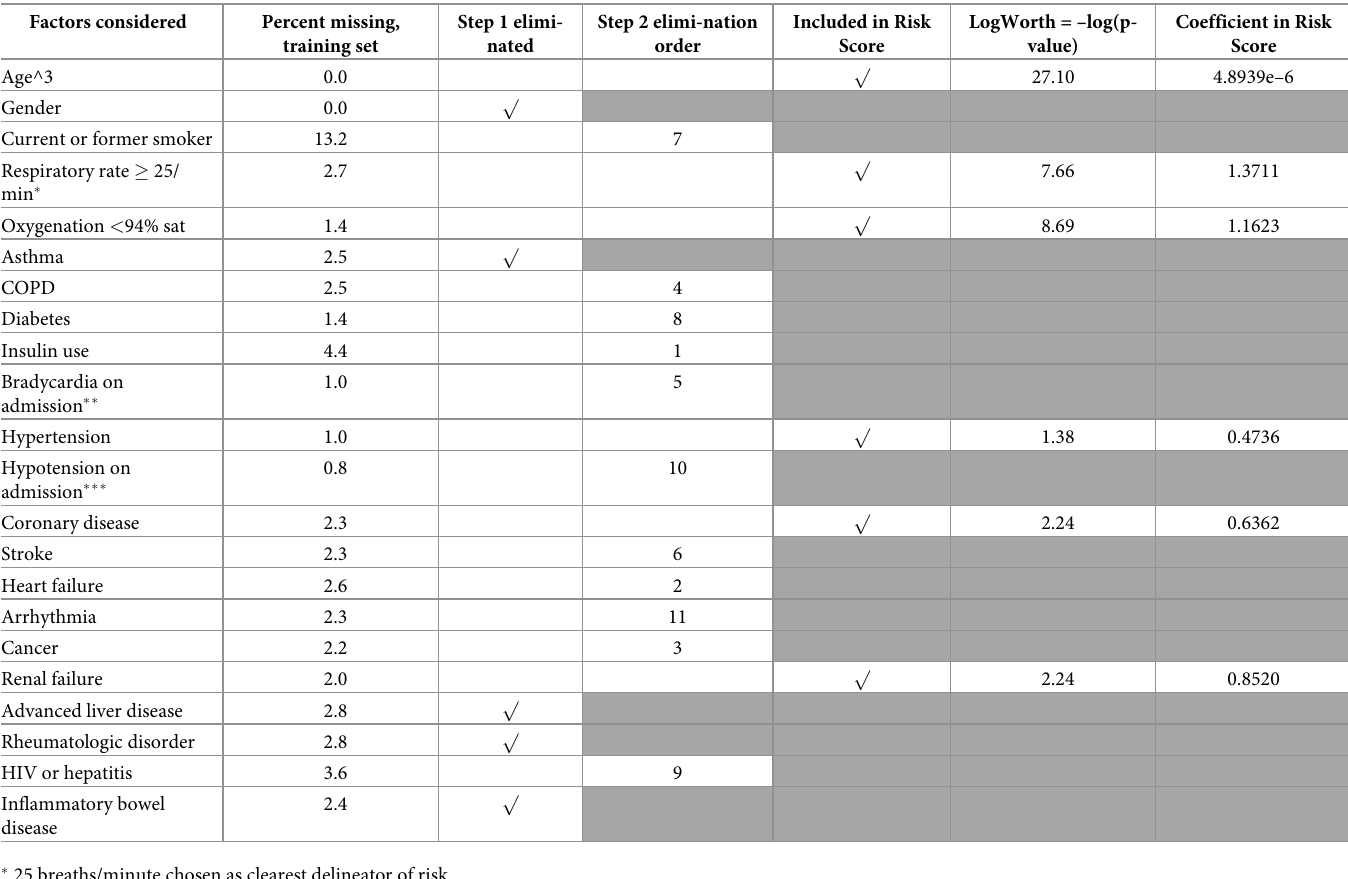
Table 1. Results of stepwise proportional hazards modeling in training set to determine factors for inclusion in risk